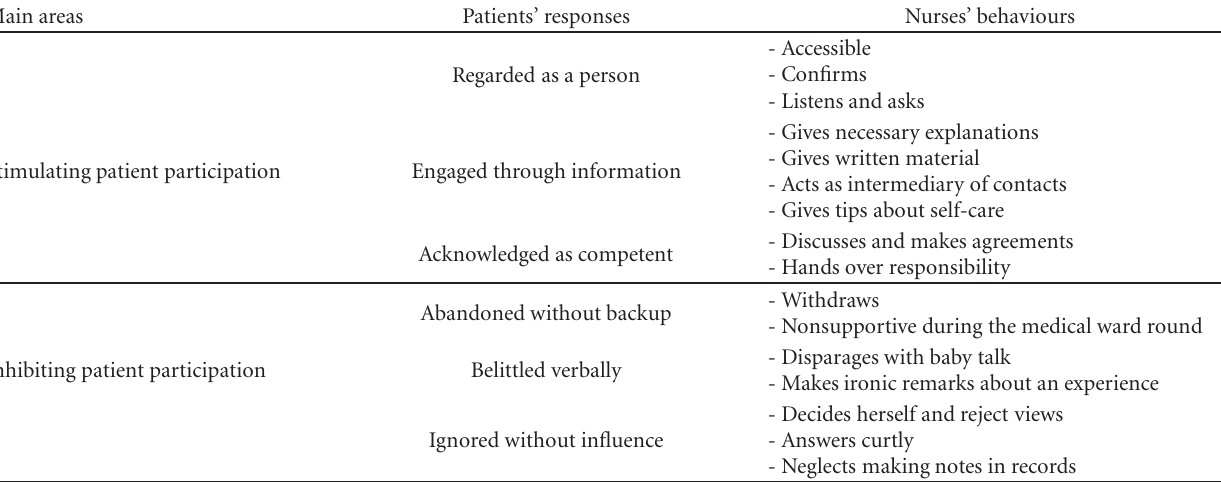
Table 2: An overview of the two main areas along with patients’ responses to nurses’ behaviours, based on patients’ narratives of critical